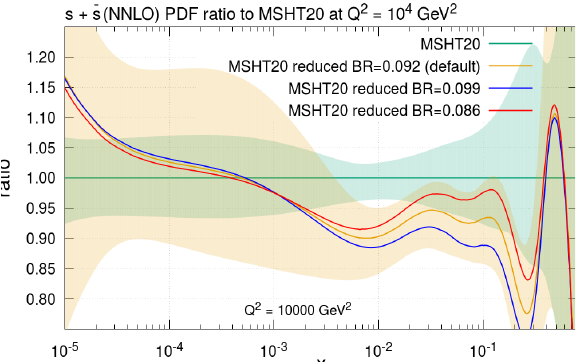
Figure 3: Effect of the charm hadrons to muon branching ratio (BR) B ( D → µ ) on the total strangeness of the MSHT reduced fit, relative to the MSHT20 global fit